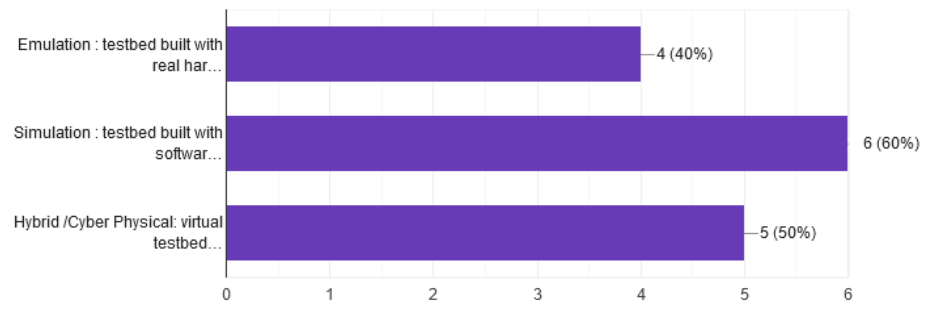
Figure 6. Types of environment.